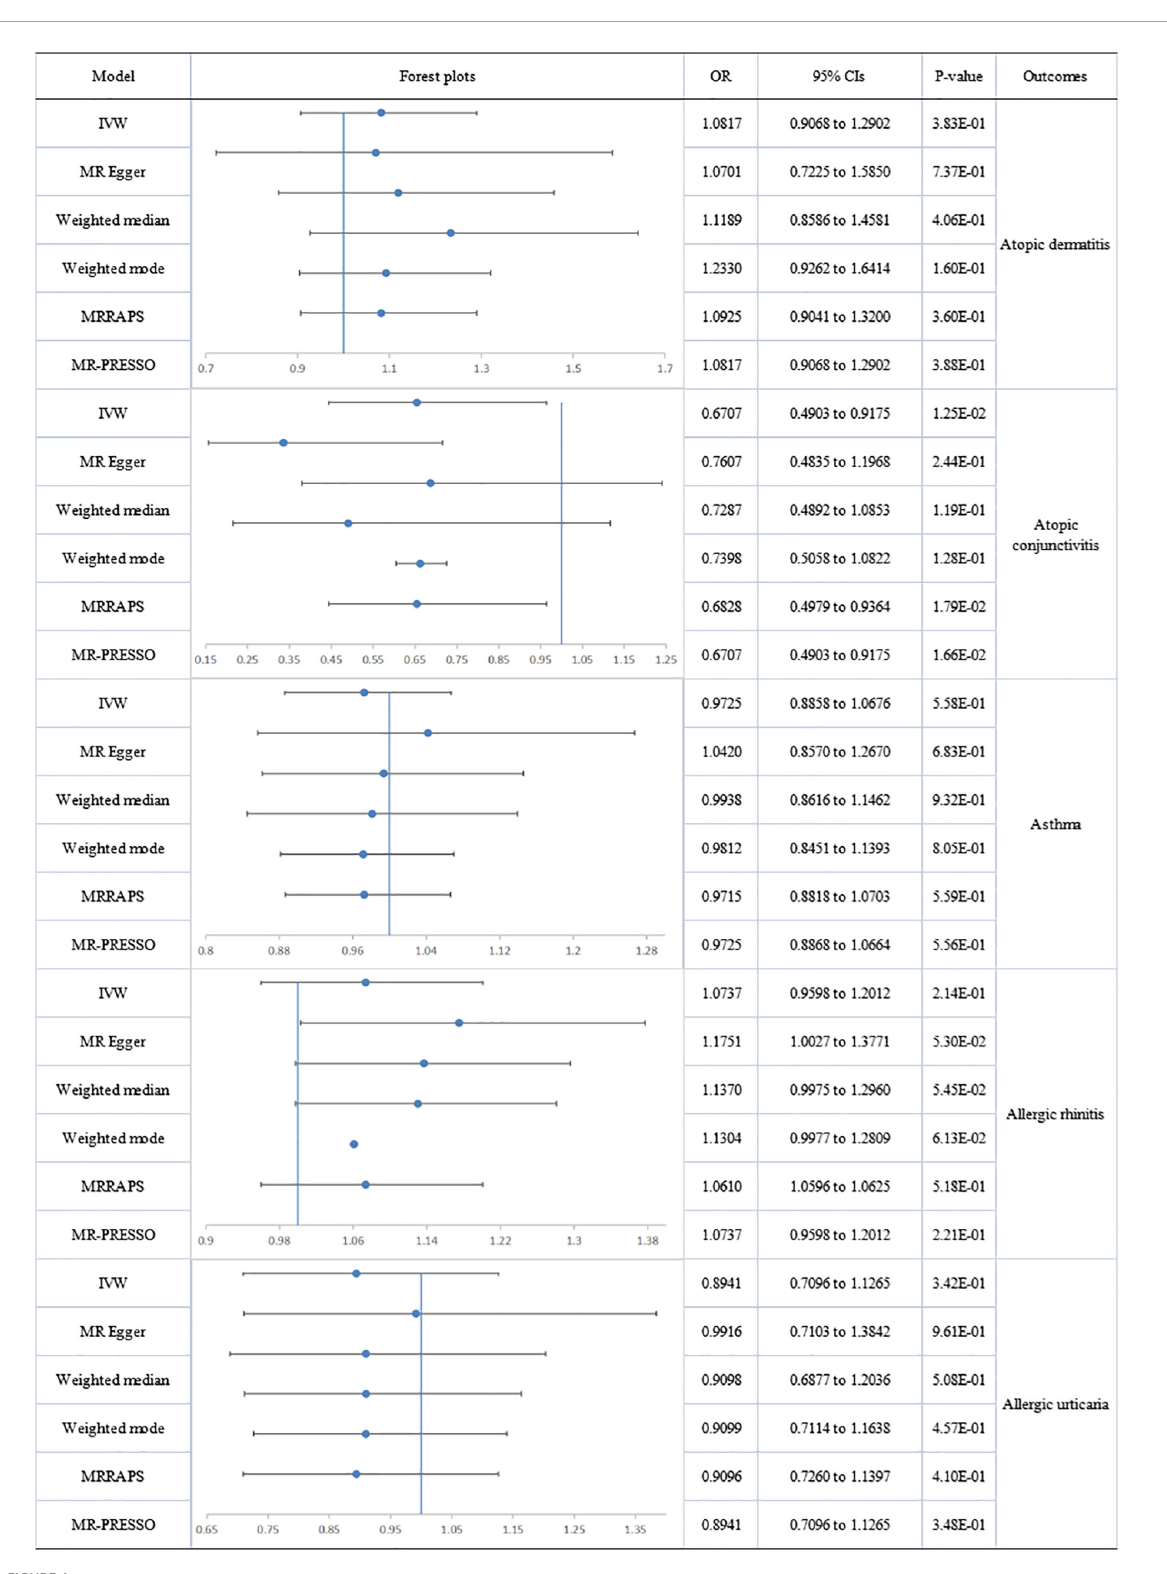
Frontiers in Nutrition